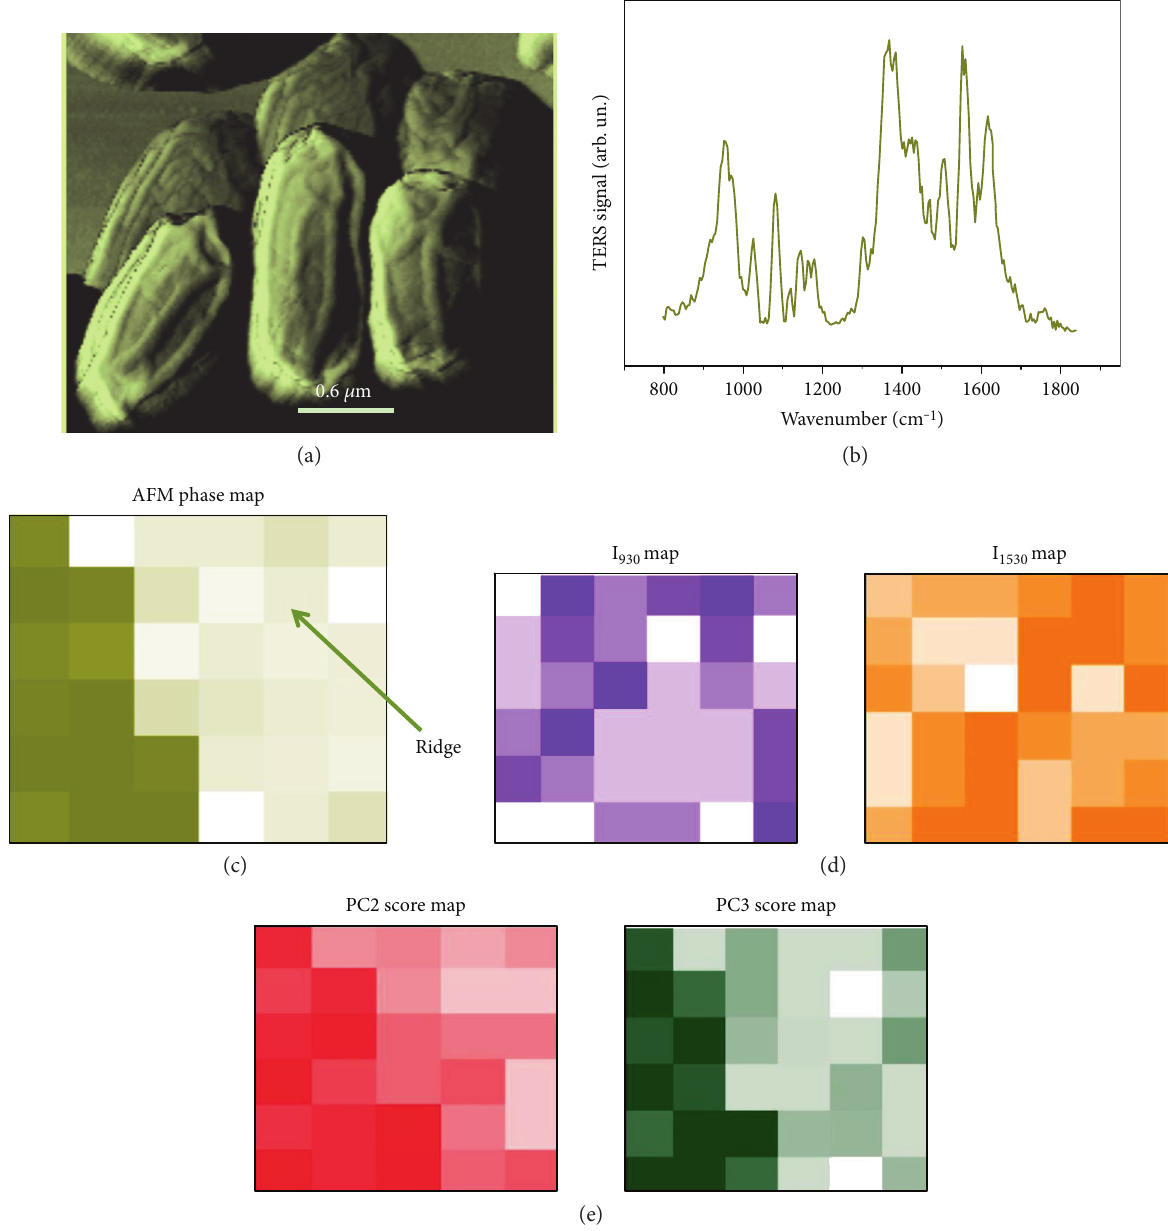
Figure 5: (a) AFM topographical image of fully dehydrated B. subtilis . Spore surface exhibits characteristic ridges resulting from volume contraction due to the core dehydration. (b) A typical TERS spectrum from the coat of a B. subtilis spore. (c) AFM phase map of a whole spore acquired in tapping mode. Bright (dark) zones correspond to regions of higher (lower) sti ff ness. (d) TERS maps obtained by reporting the intensity of selected spectral features, indicated in the labels. (e) Second and third PC score maps of TERS